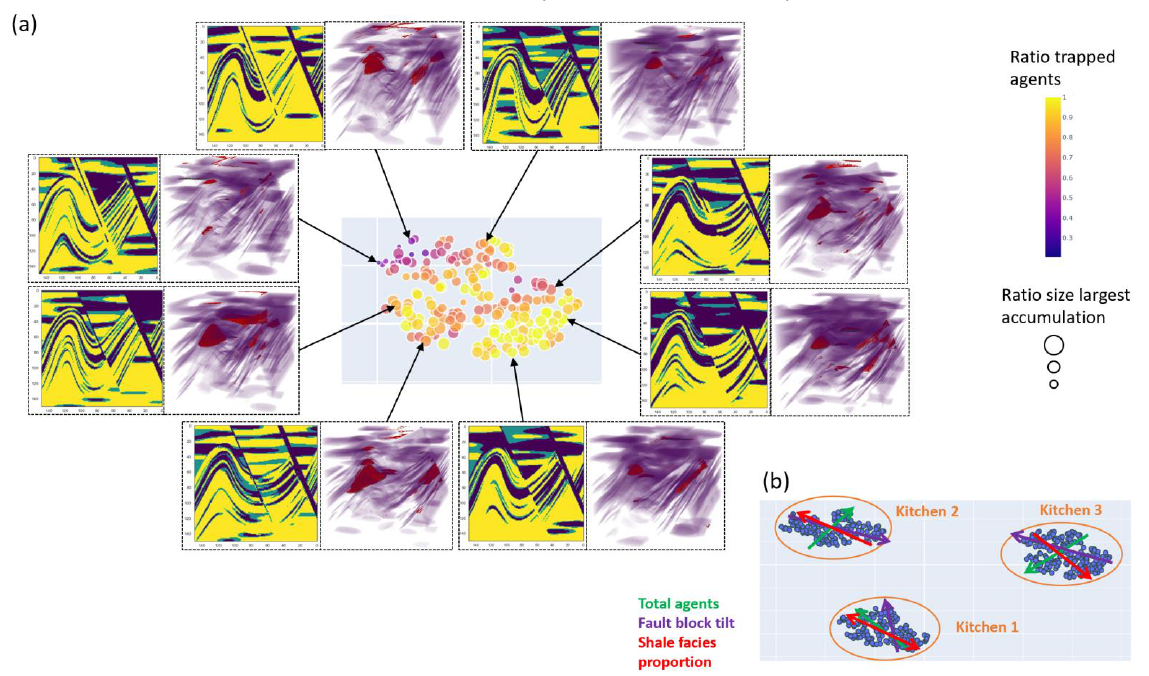
Figure A4. ( a ) t-SNE analysis of kitchen scenario 3 showing the most impactful geological uncertainties and their correlation with simulation evaluation metrics. Each point represents an individual model from the Monte Carlo simulation. The points are colour coded with the evaluation metric ratio of trapped agents and sized by the size of the most significant accumulation. One observation is that accumulations are located in the fault block and the anticline. Exemplary 2D slices of the environment and 3D plots showing the accumulation positions at the end of the simulation (red) and the barriers (purple) are also shown ( b ) Display of the trends of the original geological parameters with colour coded arrows.